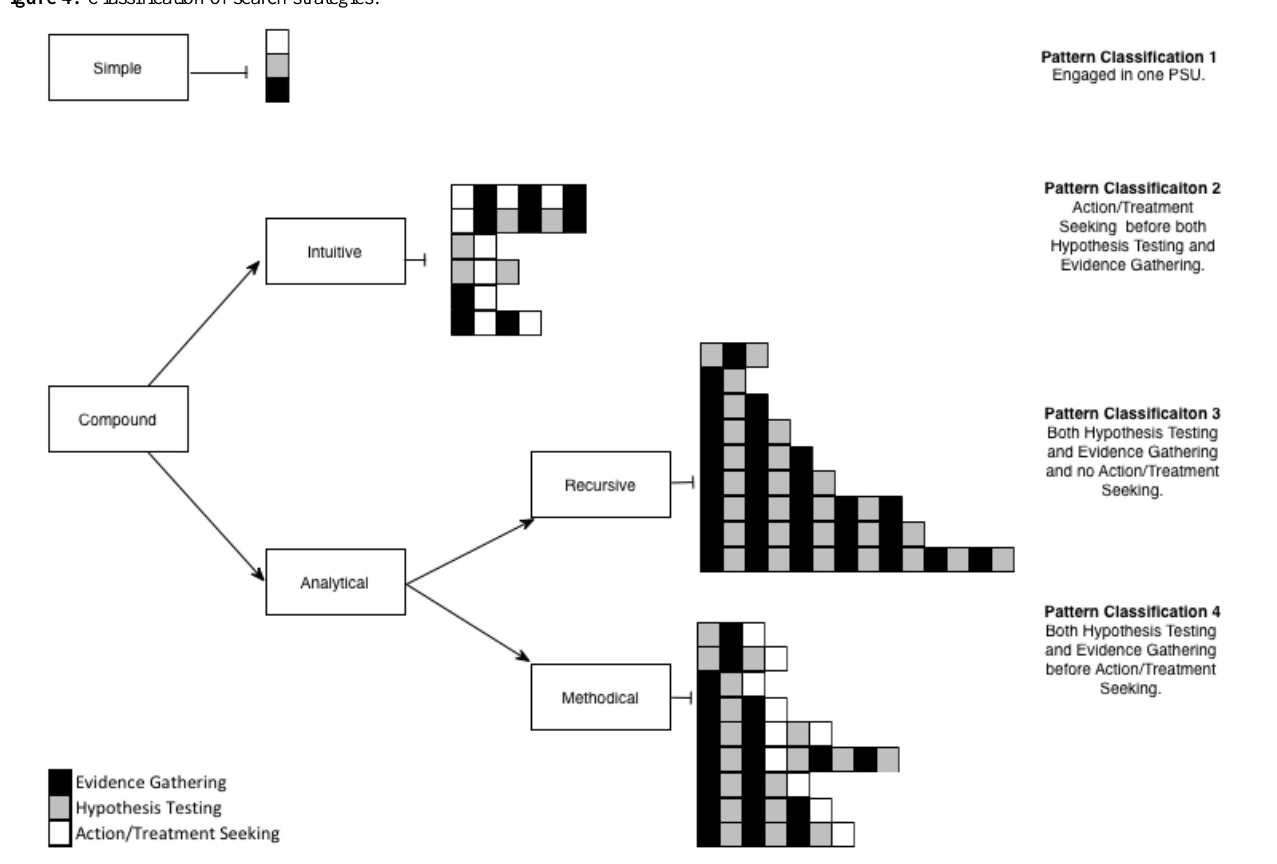
Figure 4. Classification of search